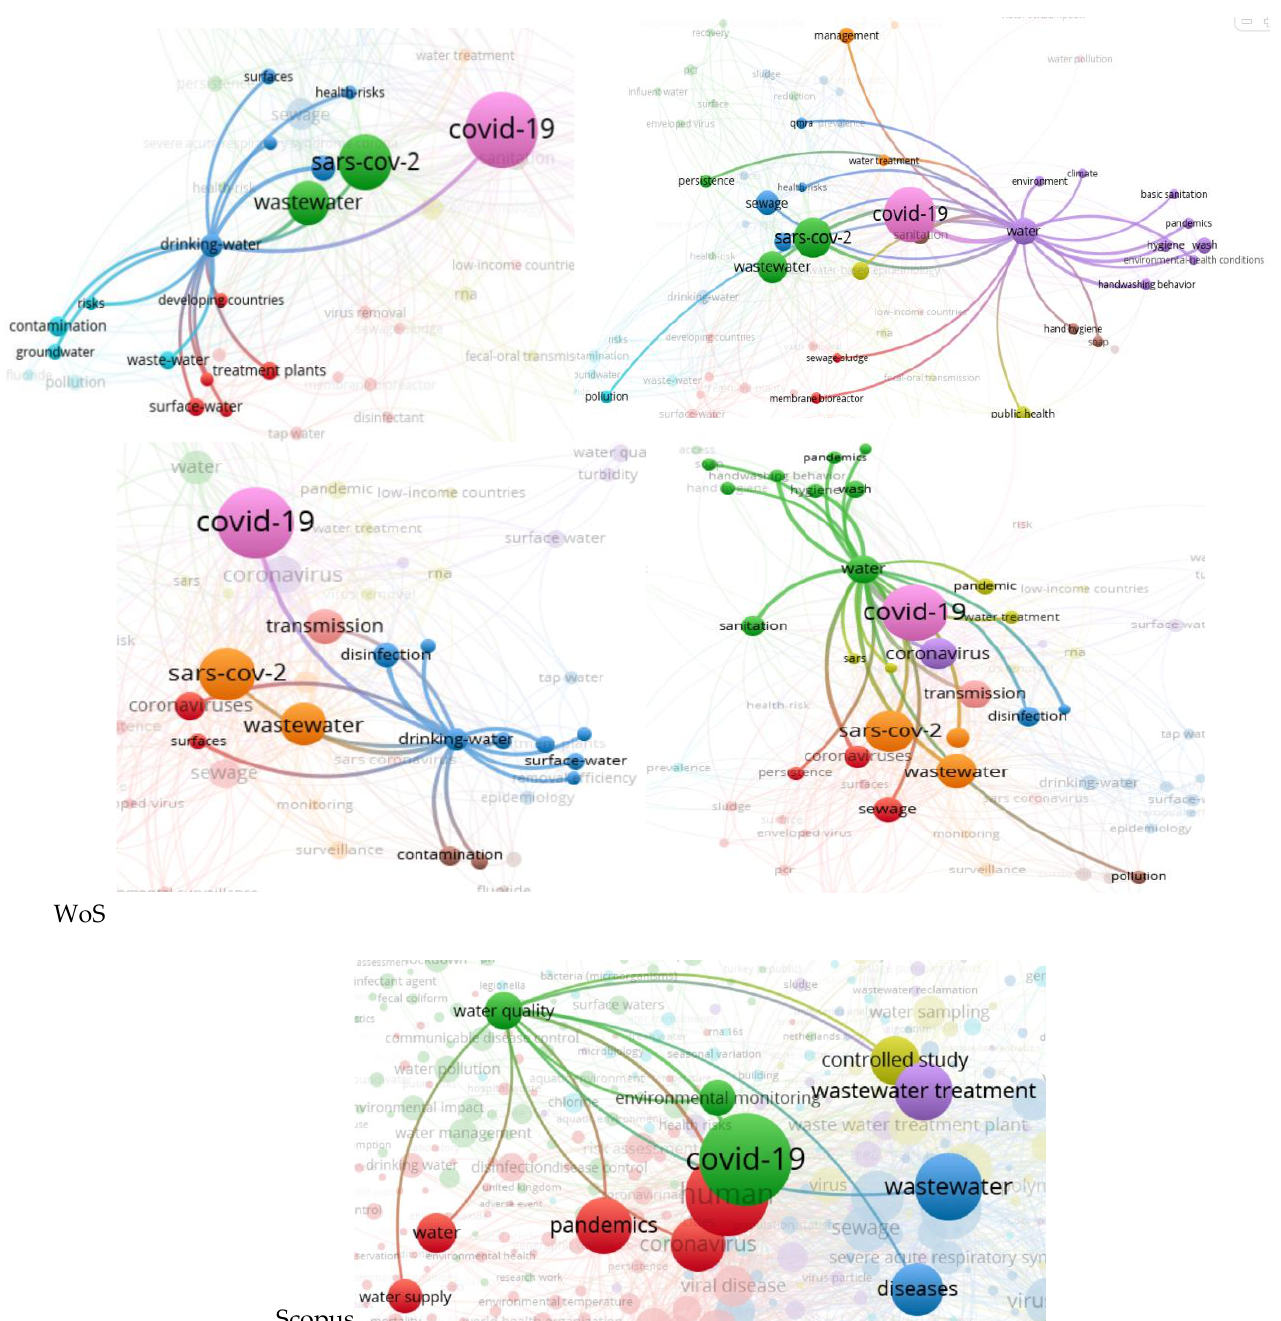
Figure 5. Co-occurrences between water, drinking water, water quality, COVID-19, and the rest of the variables (WoS and Scopus).